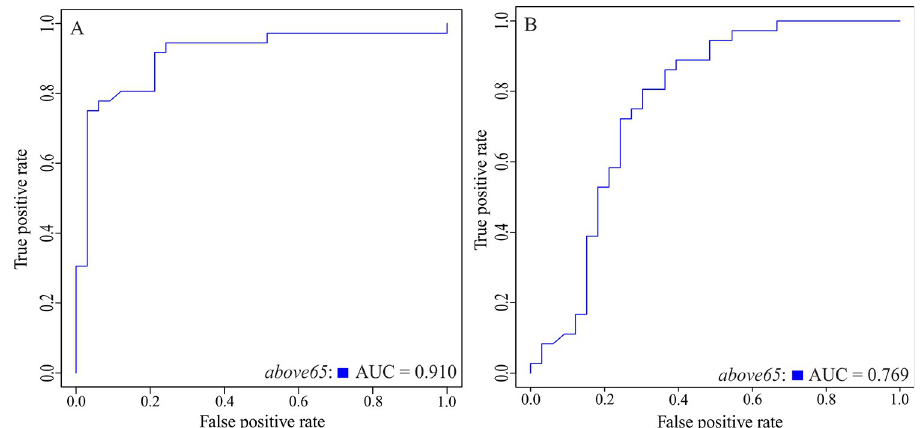
Fig 4. ROC curves for the random forest classifier for microbial abundances and pathway abundances. ROC curves visualizing the Random Forest classifier for (A) microbial abundances and (B) pathway abundances. The group above65 is represented in blue (patients aged 65 years and above; n = 145), the curve for below65 was omitted as its information is redundant. AUC, area under the curve; ROC, receiver operating characteristic.